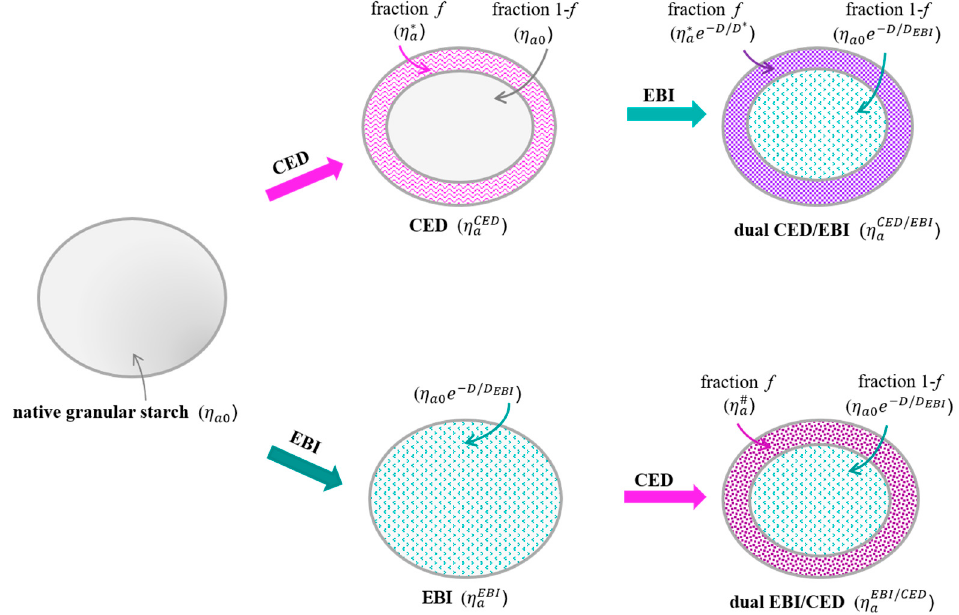
Figure 6. Schematic representation of the investigated treatments applied to the starch.